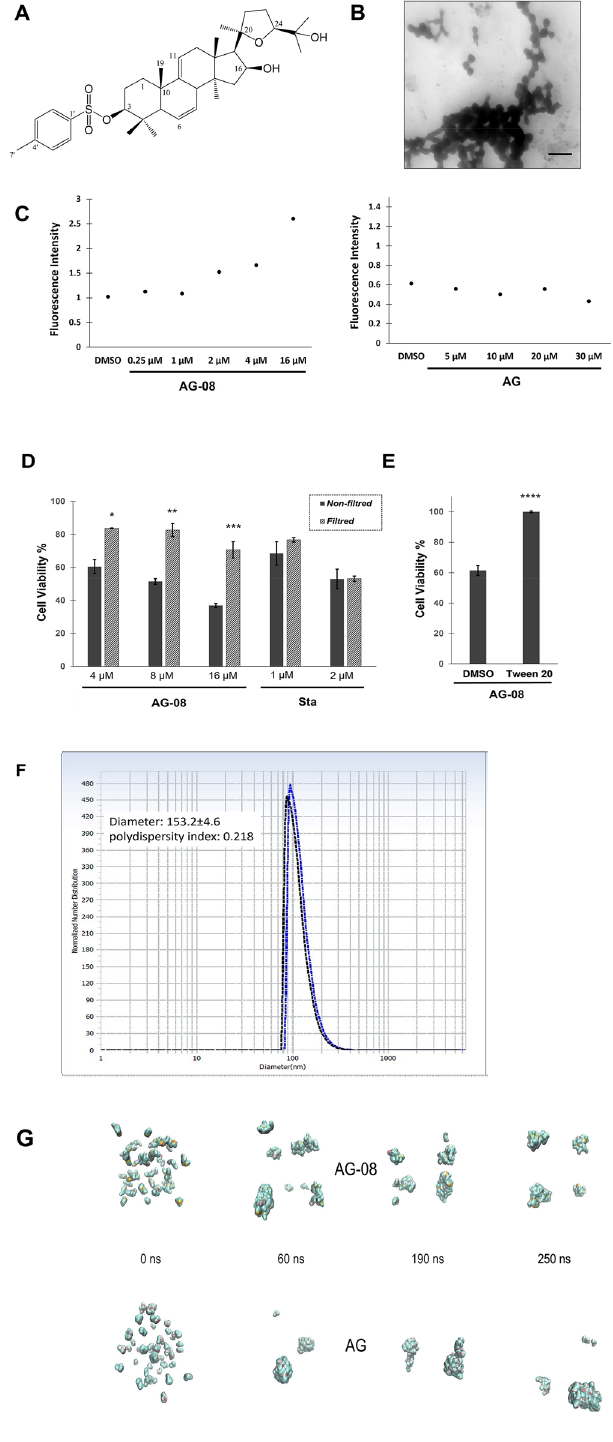
Figure 1. AG-08 mediated cytotoxicity relies on the supramolecular structures. ( A ) Structure of AG-08. ( B ) The scanning transmission electron micrograph of 16 µM AG-08 in PBS. Figure is a representative image of stained sample with uranyl acetate (5683 × magnification; scale bar 600 nm). ( C ) After 3 h incubation of Nile red solution with AG-08 or AG, fluorescence intensity of Nile red was measured. ( D ) AG-08, Staurosporine (Sta) or vehicle samples prepared in the cell condition medium was filtrated by 220 nm filter and HCC1937 cells were exposed to the filtrates. After 24 h, the viability of cells was measured and represented as a percentage of that of the vehicle control. The error bars represent mean value ± s.d. (n = 3). *p < 0.05, **p < 0.005, ***p < 0.001. ( E ) Tween 20 (1:40,000) was added to the fresh medium before addition of 8 μM AG-08 or vehicle. Then cell medium was replaced with this fresh medium. Cell viability was detected after 24 h incubation. Error bars are the standard deviations (n = 3; ****p < 0.0001) ( F ) Hydrodynamic diameter of AG-08 based supramolecular structures ( G ) AG and AG-08 form aggregates at 60 nM concentration in MD